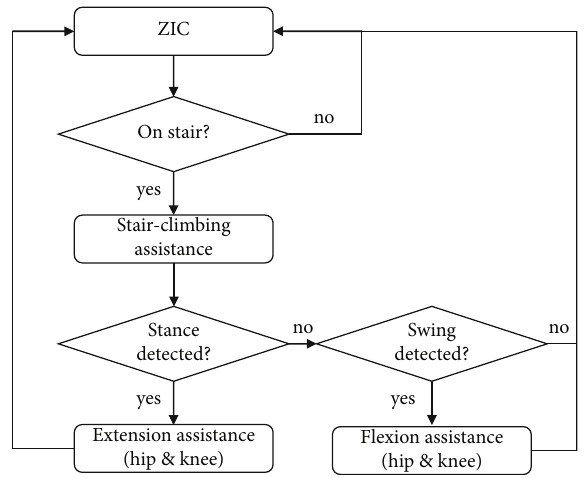
Figure 3: Work fl ow schematic of the stair-climbing assistance provided by the robotic exoskeleton. ZIC: zero-impedance control. Table 1: De fi ned assistive torque parameters. τ p : peak value of the assistive torque; t p : time taken to reach the τ p .